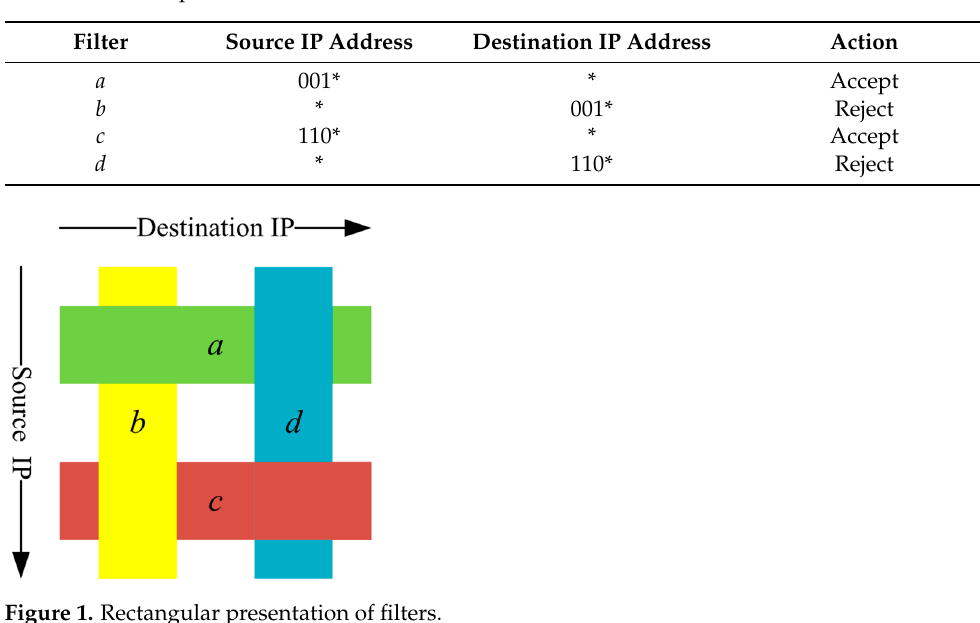
Table 1. An example of a 2D filter database.